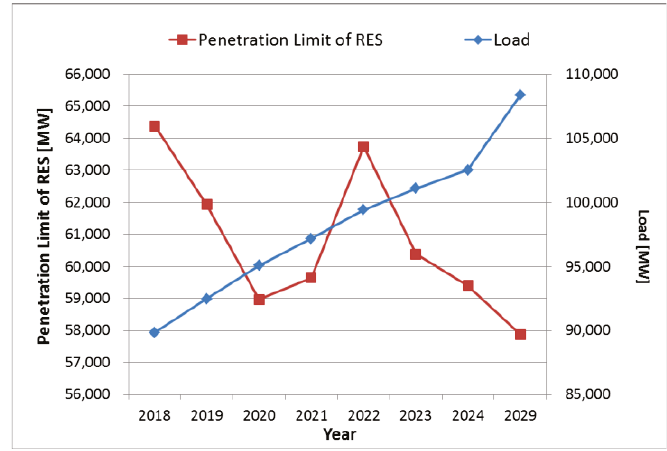
Figure 7. Penetration limit of RES calculated using the 10-min reserve.